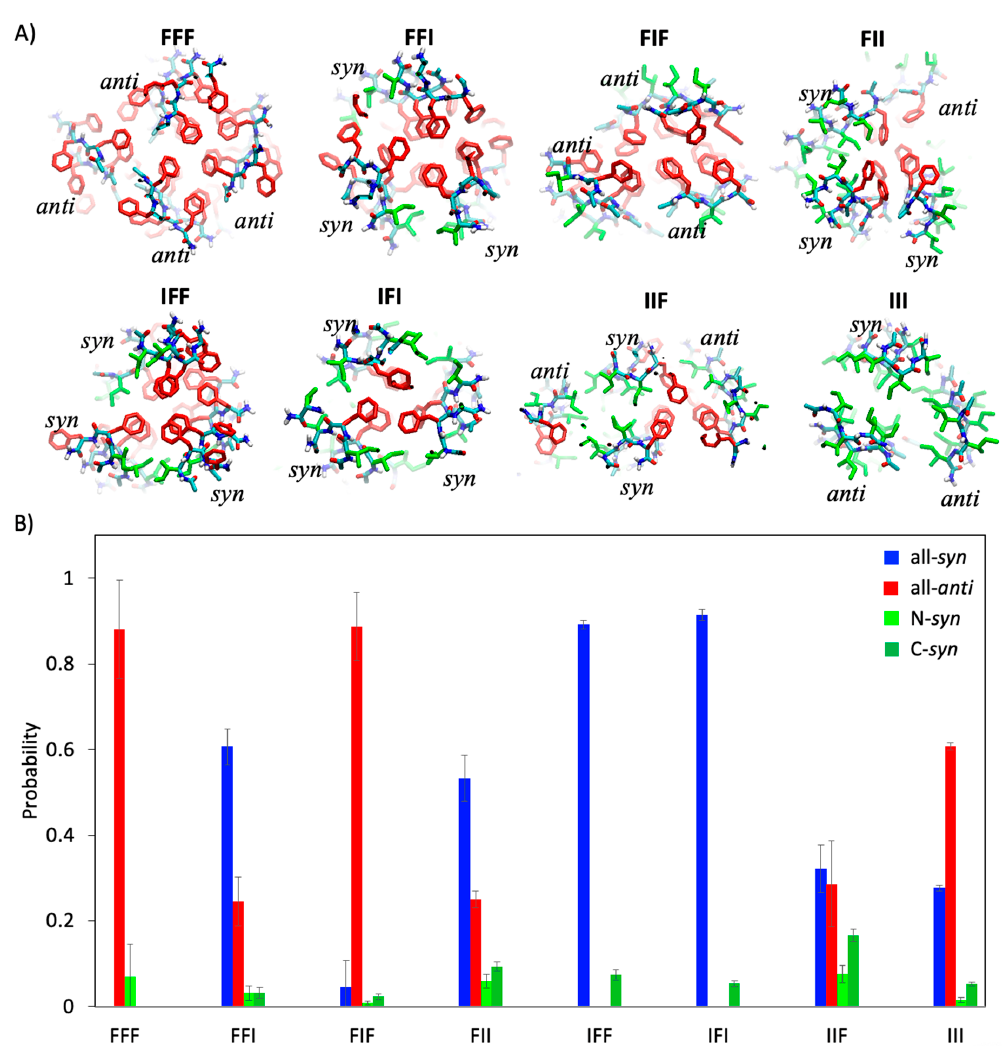
Figure 3. ( A ) Cross-section view of assembled structures of tripeptides. The red and green sticks denote the sidechains of Phe and Ile, respectively. ( B ) The probabilities of peptides with all- syn (blue bars), all- anti (red bars), N- syn (light green bars), and C- syn (green bars) topologies. All error bars were obtained using three independent simulations.